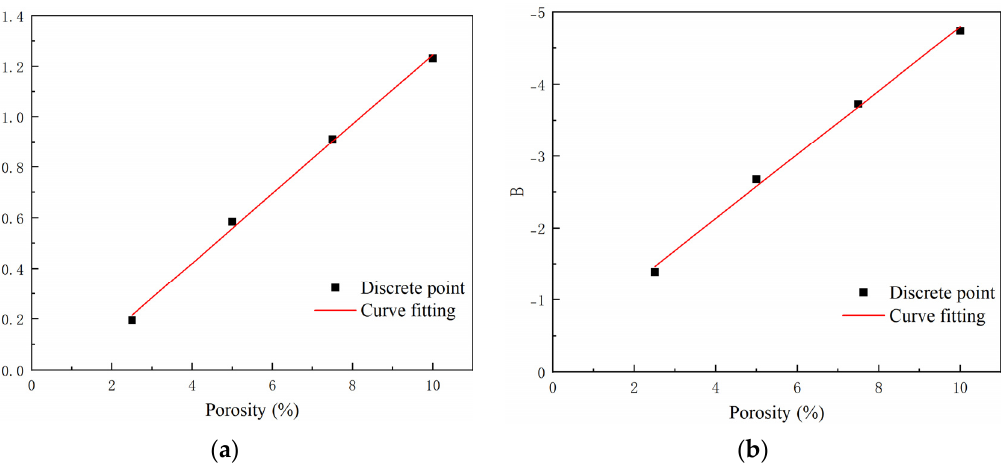
Figure 7. Fitting curves of parameters A and B vs. porosity. ( a ) Fitting curve of parameter A and porosity. ( b ) Fitting curve of parameter B and porosity.